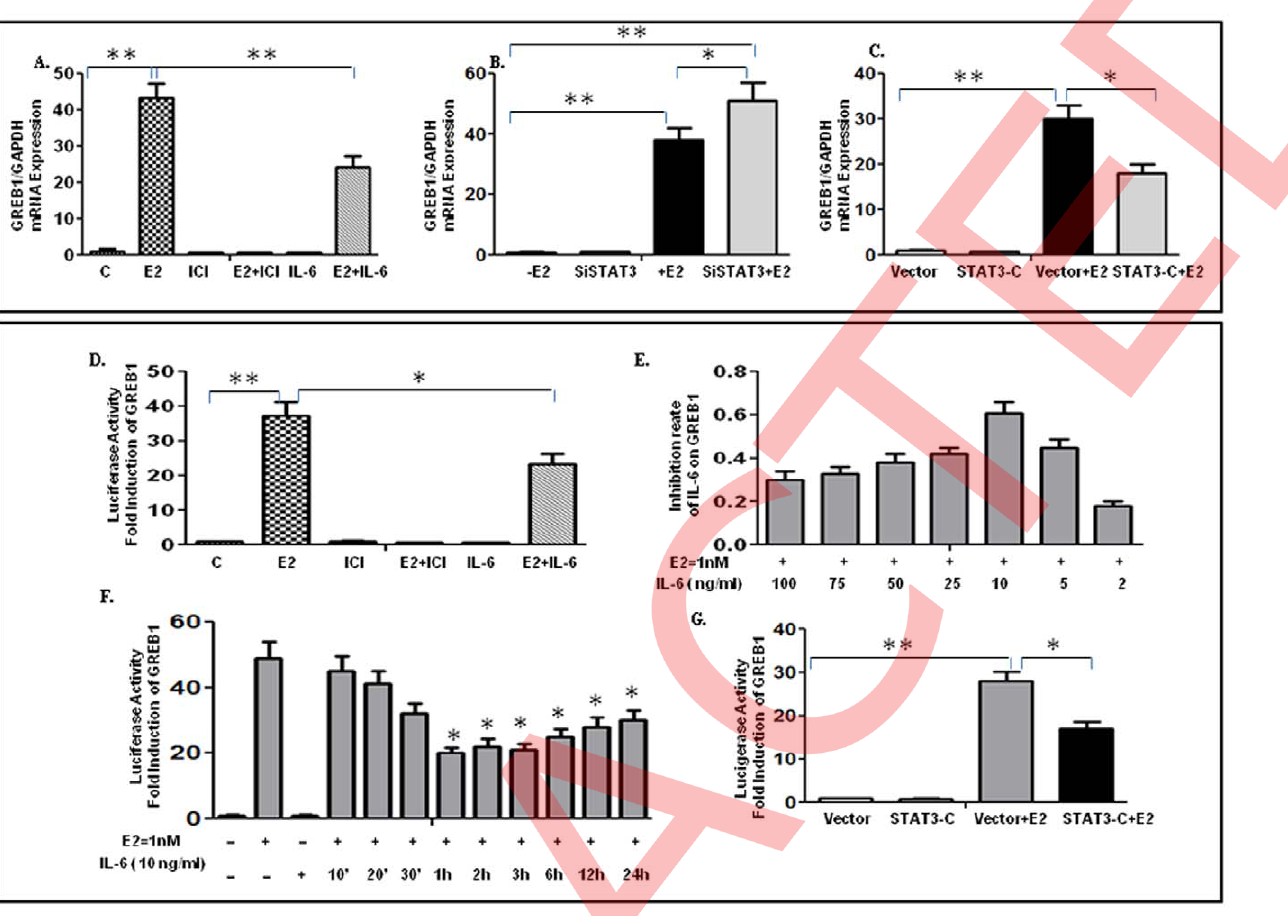
Figure 5. IL6/STAT3 modulates estrogen-induced GREB1 transcriptional activity in breast cancer cells. E2 treatment increases GREB1 mRNA levels by approximately 43-fold after 48 h treatment (Figure 5A). ICI abolishes E2-induced GREB1 expression. IL-6 has an inhibitory effect on GREB1 expression, which inhibits GREB1 expression by approximately 44% (Figure 5A). Transfection with STAT3 siRNA (SiSTAT3) duplexes increased E2 induced expression of GREB1 (Figure 5B) whereas transfection with constitutively active STAT3 vector (STAT3-C) suppressed E2 induced expression of GREB1 (Figure 5C). Figure 5D to 5G, MCF-7 cells were estrogen deprived for 3 days before transfection with 0.5 m g luciferase GREB1 promoter- reporter construct and 0.1 ug phRL-SV40 Renilla internal control. The following day, transfected cells were refed with medium containing 1 nM E2 and 10 ng/ml IL-6 for a further 24 h before lysis and measurement of luciferase activity. As shown in Figure 5D, E2 treatment increases luciferase activity by approximately 37-fold over the control. Estrogen receptor antagonist ICI blocks the E2-mediated GREB1 induction. IL-6 inhibits E2-induced GREB1 transcriptional activity by approximately 38%. To determine the best efficient concentration for IL-6, hormone-starved MCF-7 cells were treated with various concentrations of IL-6 (0 , 100 ng/ml) for 24 h. Figure 5E shows that the maximum reduction of E2-mediated GREB1 activity is seen at 10 ng/ml, the inhibitory effects are decreased regardless of whether the doses are further increased or decreased throughout the experiment. In time course experiments, cells were treated with 10 ng/ml IL-6 at indicated time,. Pretreatment with IL-6 for less than half an hour dampered the antagonist function of IL-6 on suppression of E2-induced GREB1 greatly (Figure 5F). MCF-7 cells were then cotransfected with a GREB1 luciferase reporter construct, a STAT3 constitutively expressing vector (STAT3-C) and control vector respectively. The samples were treated with E2 as